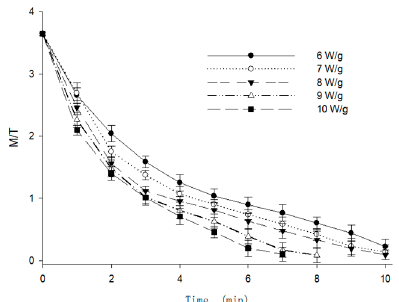
Figure 7. Changes in the moisture content to temperature ratio ( M/T ) of berry puree under different microwave intensities during microwave assisted foam ‐ mat drying (MFD).